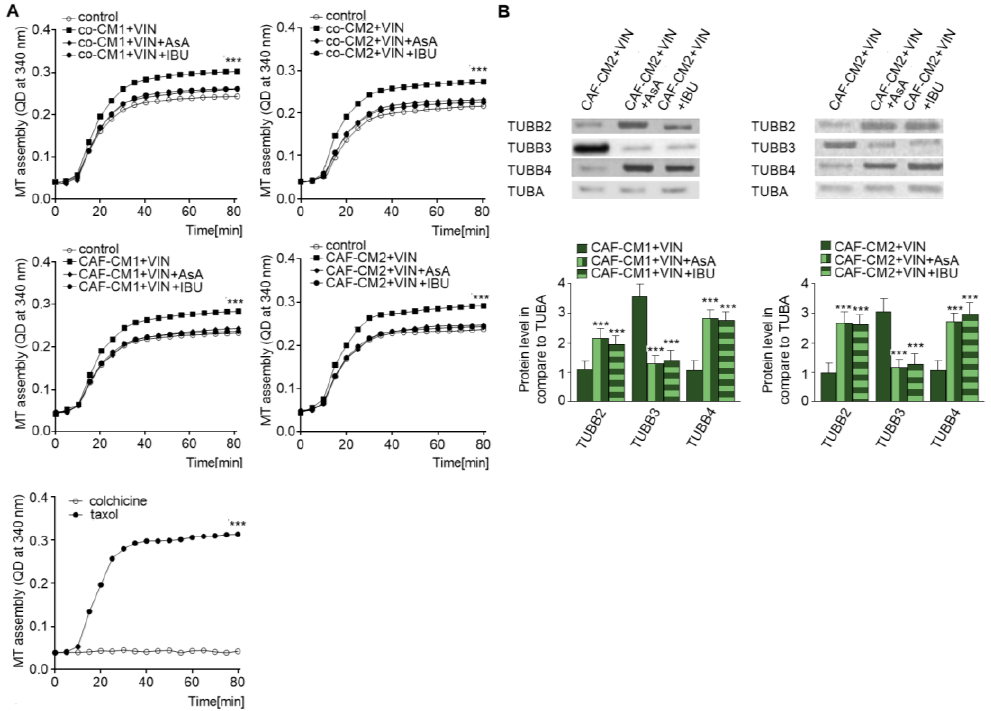
Figure 6. NSAIDs decrease microtubules polymerization through modulation of the composition of beta subunits in microtubules. The polymerization ability was analyzed in microtubules isolated from coculture of CAF-like cells and colon cancer, or CAF-like cells maintained in CM colon cancer cells and treated with vincristine and NSAIDs (IBU or AsA) ( A ). Additionally, controls of microtubules polymerization with taxol and depolymerization with colchicine were conducted and are shown in the bottom graph (representative). Next, the levels of TUBB2, TUBB3, and TUBB4 were determined by Western blot assay in microtubules fraction of CAF-like cells ( B ). The protein levels were normalized to TUBA. The results are provided as means ± SD ( n = 3); *** p < 0.005. The blots are representative of three independent experiments.